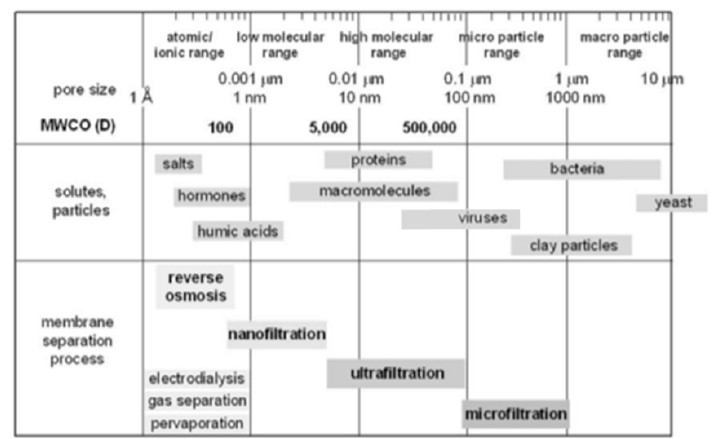
Figure 1. Membrane separation processes, pore sizes, molecular weight cut-off (MWCO) and typical solutes and particles sizes, adapted from references [26,27] .